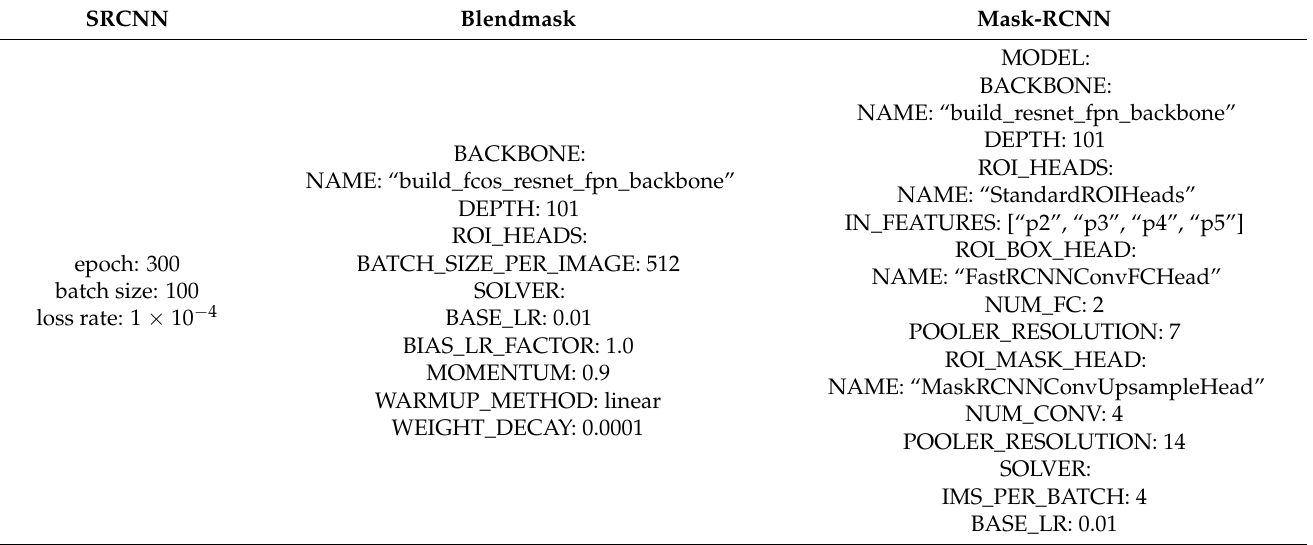
Table 1. SRCNN, Blendmask, and Mask-RCNN main parameters. SRCNN Blendmask